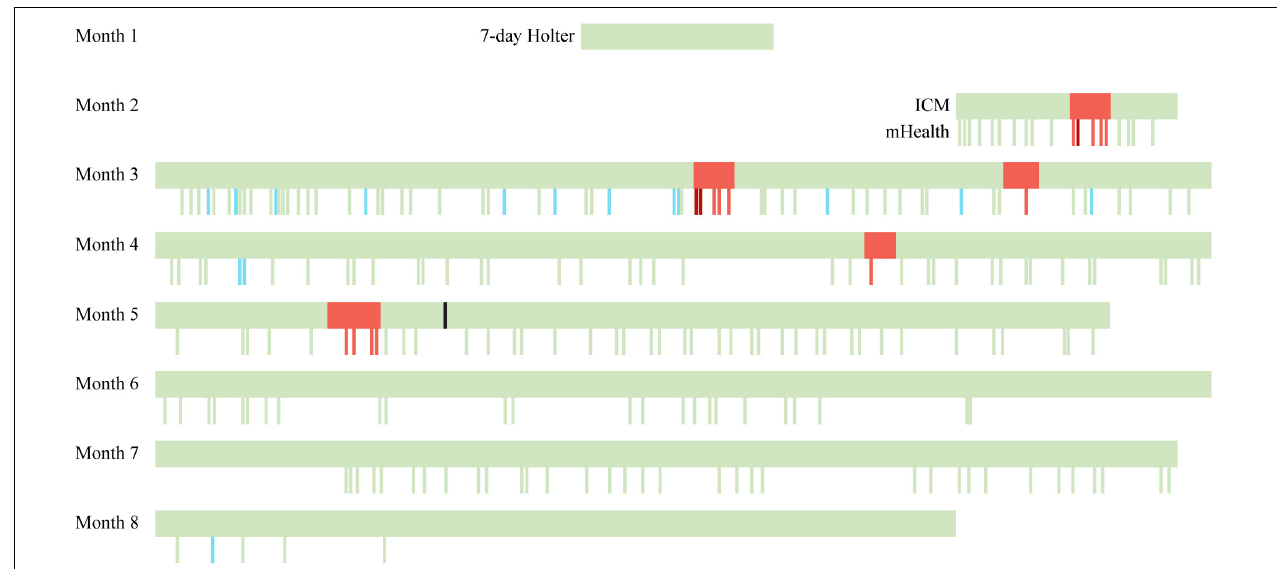
FIGURE 2 | Timeline of continuous and spot-check measurements performed by ICM and mHealth. A seven-day ECG Holter was used in the first month. At the end of the second month, the ICM was inserted, and the use of PPG-based mHealth was initiated. Green bars indicate a sinus rhythm, red bars indicate an AF episode, dark red bars indicate a symptomatic AF episode as reported in the mHealth app, blue bars indicate insufficient data quality, and the black bar indicates the ablation. ICM, insertable cardiac monitor; mHealth, mobile